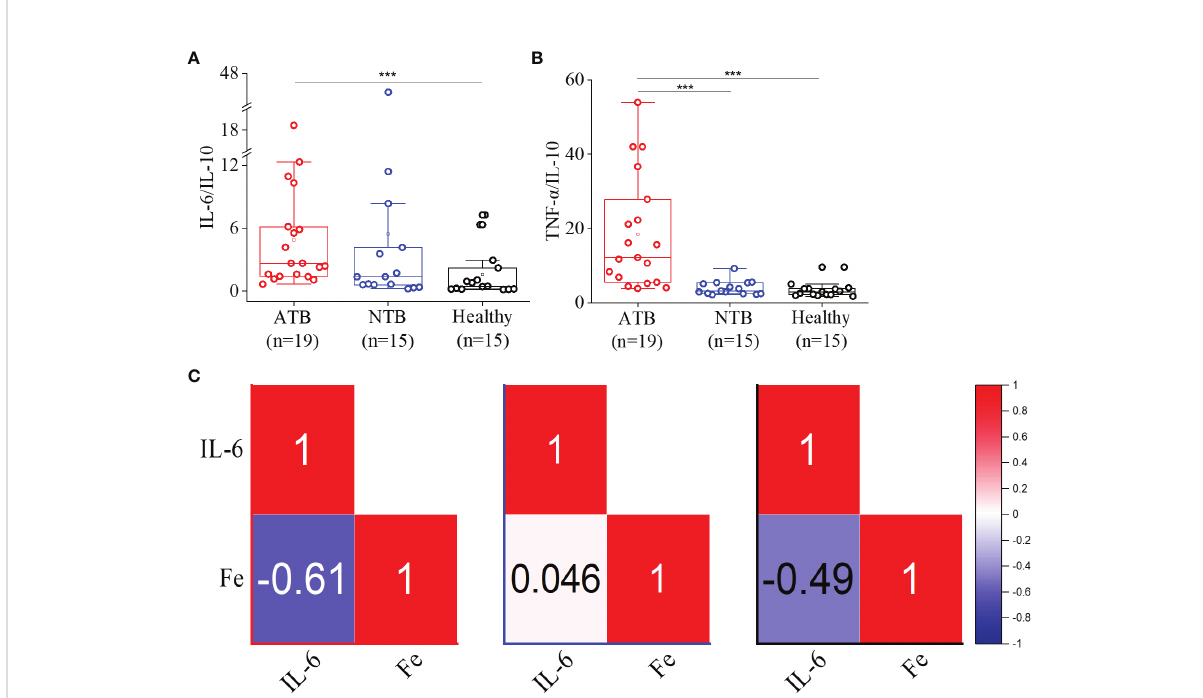
FIGURE 4 Higher IL-6/IL-10 and TNF- a /IL-10 ratios observed in ATB patients. Box plots for IL-6/IL-10 (A) and TNF a /IL-10 (B) ratios in the ATB, NTB, and healthy study groups. Correlation (Pearson r ) values between the serum IL-6 and iron (Fe) levels in active tuberculosis (ATB), non-tuberculosis (NTB), and healthy control groups (C) (*** p <